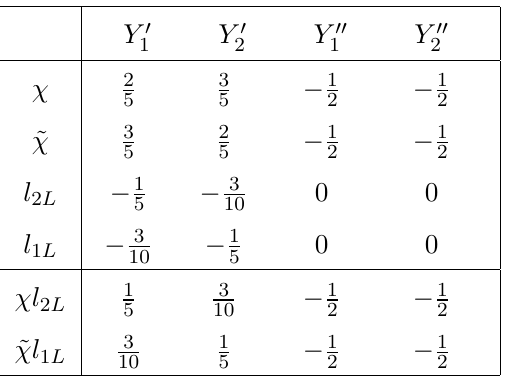
(cid:2) U(1) 0 (cid:2) U(1) 00 (cid:2) U(1) 00 , where the (cid:12)rst two single prime 1 2 1 2 + Y 00 ; b = 1 ; 2 where the total sum b b